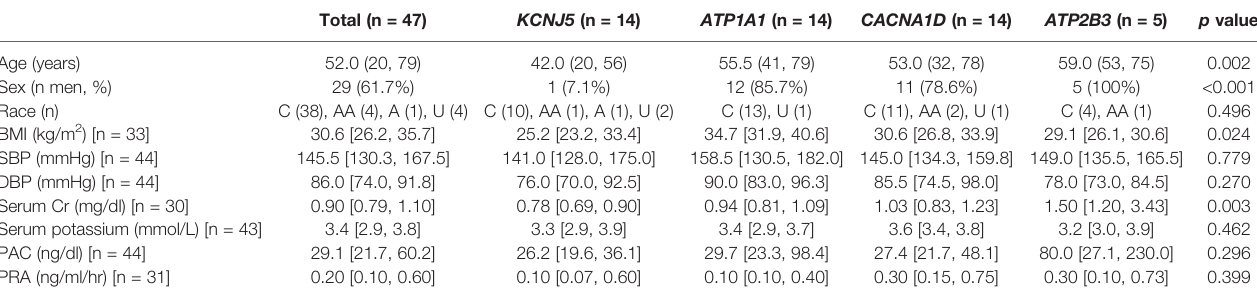
TABLE 1 | Baseline characteristics of patients with APA participating in this